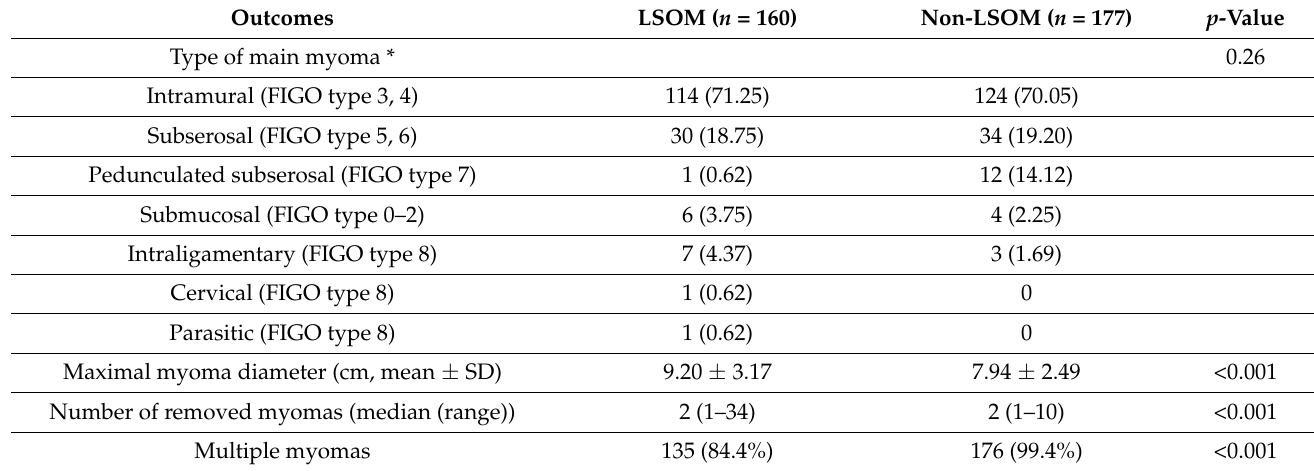
Table 2. Comparison of operative and perioperative